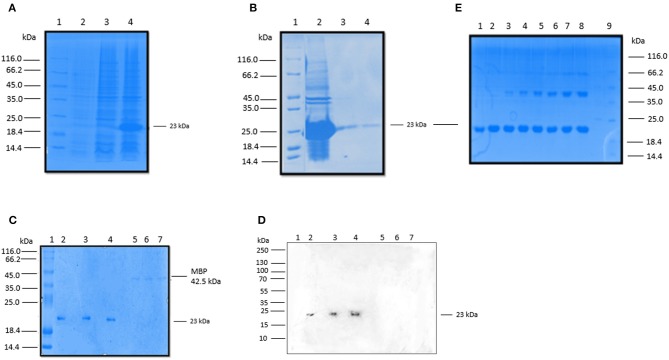
Expression and purification rfBC. (A) Recombinant bovine conglutinin (rfBC) containing the homotrimeric neck and CRD regions was expressed in E. coli BL21(λDE3) pLysS. 3 h after induction with 0.4 mM IPTG, rfBC accumulated as an over-expressed protein of ~23 kDa (lane 3) compared to uninduced cells (lane 2) and was observed as inclusion bodies (lane 4). Samples were resolved on a SDS-PAGE (12% w/v gel), followed by Coomassie staining. Protein marker (lane 1). (B) Purification of rfBC from inclusion bodies (lane 2) using denaturing and refolding in urea, followed by affinity chromatography on an agarose-N-acetylglucosamine column. The affinity-purified rfBC (Lane 3), was made LPS-free prior to use (lane 4). Samples were resolved on a SDS-PAGE (12% w/v gel), followed by Coomassie staining. Protein marker (lane 1). (C) Purified LPS-free rfBC verified by 12% SDS-PAGE, with 20 μg/ml of protein loaded in triplicate (lanes 2, 3, and 4), together with a negative control of 5 μg/ml of maltose binding protein (MBP) loaded also in triplicate (lanes 5, 6, and 7). Lane 1 is protein marker. (D) Western blot analysis confirms the identity and purity of rfBC (lanes 2, 3, and 4), using rabbit anti-bovine conglutinin. Western blotting with anti-MBP (not shown) confirmed no reaction with rfBC and reaction with 42.5 kDa MBP. (E) Chemical cross-linking of purified rfBC to show that it could form dimeric and trimeric structures. 20 μg/ml of rfBC were incubated with 1 mM BS3 [bis(sulfosuccinimidyl)suberate] for 0 min (lane 1), 1 min (lane 2), 2 min (lane 3), 4 min (lane 4), 8 min (Lane 5), 16 min (Lane 6), 32 min (lane 7), 64 min (lane 8). Protein marker (lane 9). Samples were resolved on a SDS-PAGE (12% w/v gel) followed by Coomassie staining and show dimers at 46 kDa and trimers at 69 kDa.